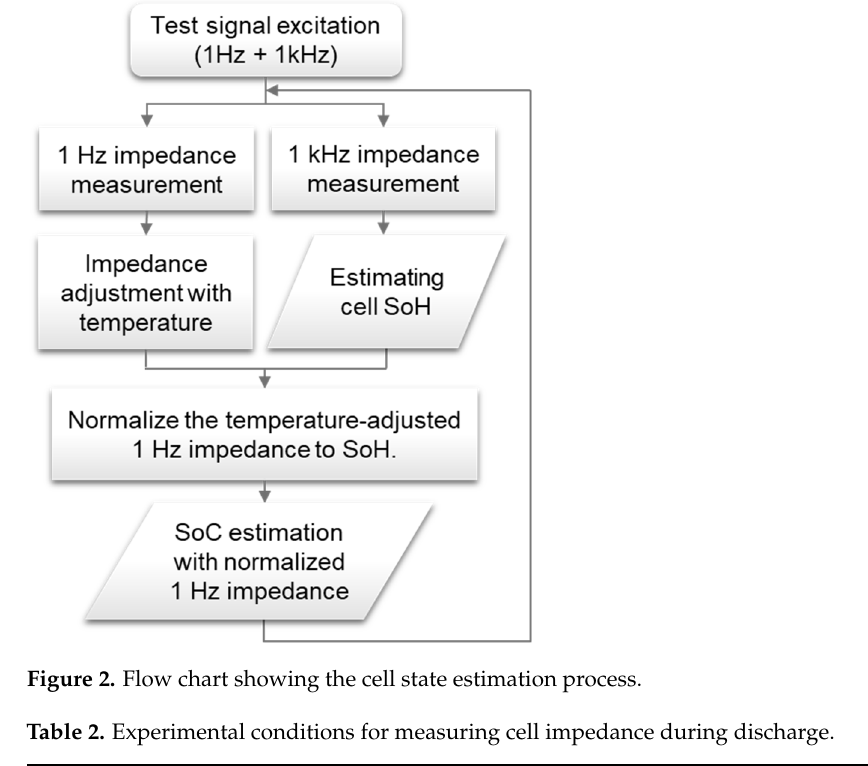
Figure 2. Flow chart showing the cell state estimation process. Table 2. Experimental conditions for measuring cell impedance during discharge.